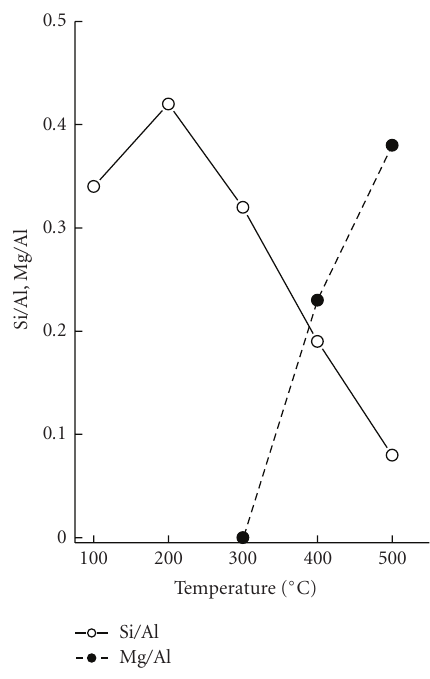
Figure 6: Variation of Mg/Al and Si/Al ratios with the temperature for the untreated